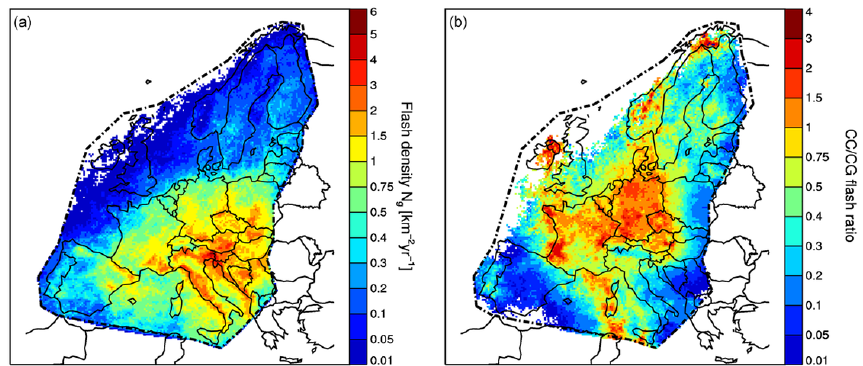
Figure 3. (a) Mean annual CG flash density [km − 2 yr − 1 ], and (b) CC/CG flash density ratio, based on 2006–2014 EUCLID data and adopting a spatial resolution of 20km ×